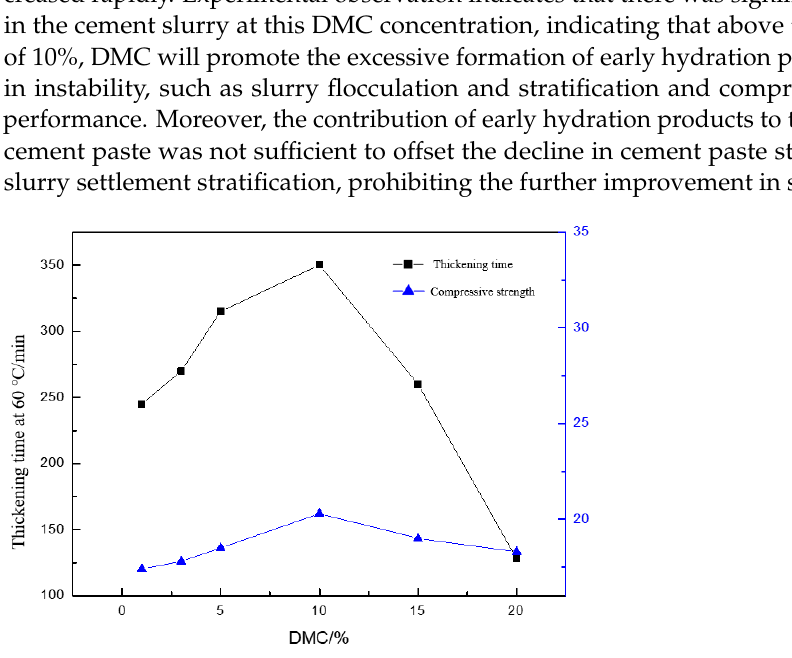
Figure 8. Thickening curve of polymeric ion retarder from 120 °C to 60 °C.